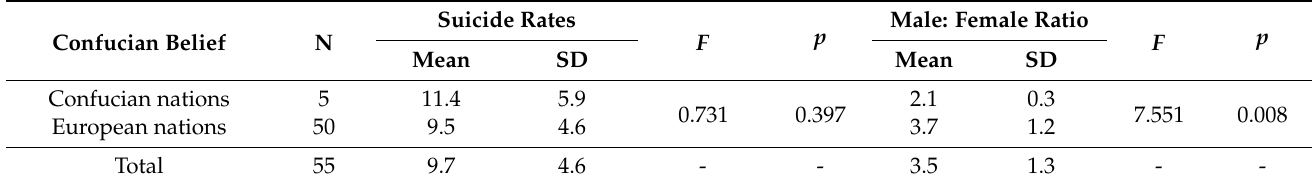
Table 2. Comparison between the Confucian and European countries in the suicide rates and the gender ratios.